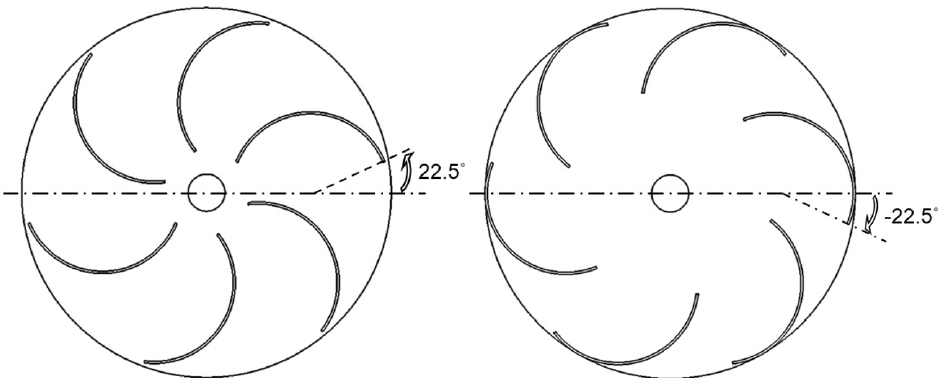
Figure 3. The geometry of the turbine blades at different placement angles ( α =